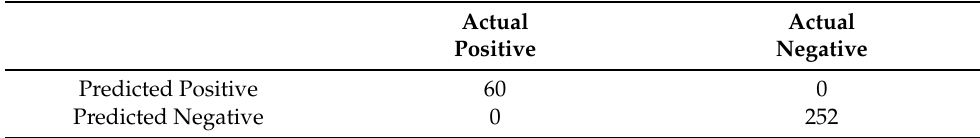
Table 2. Confusion matrix for the training set.